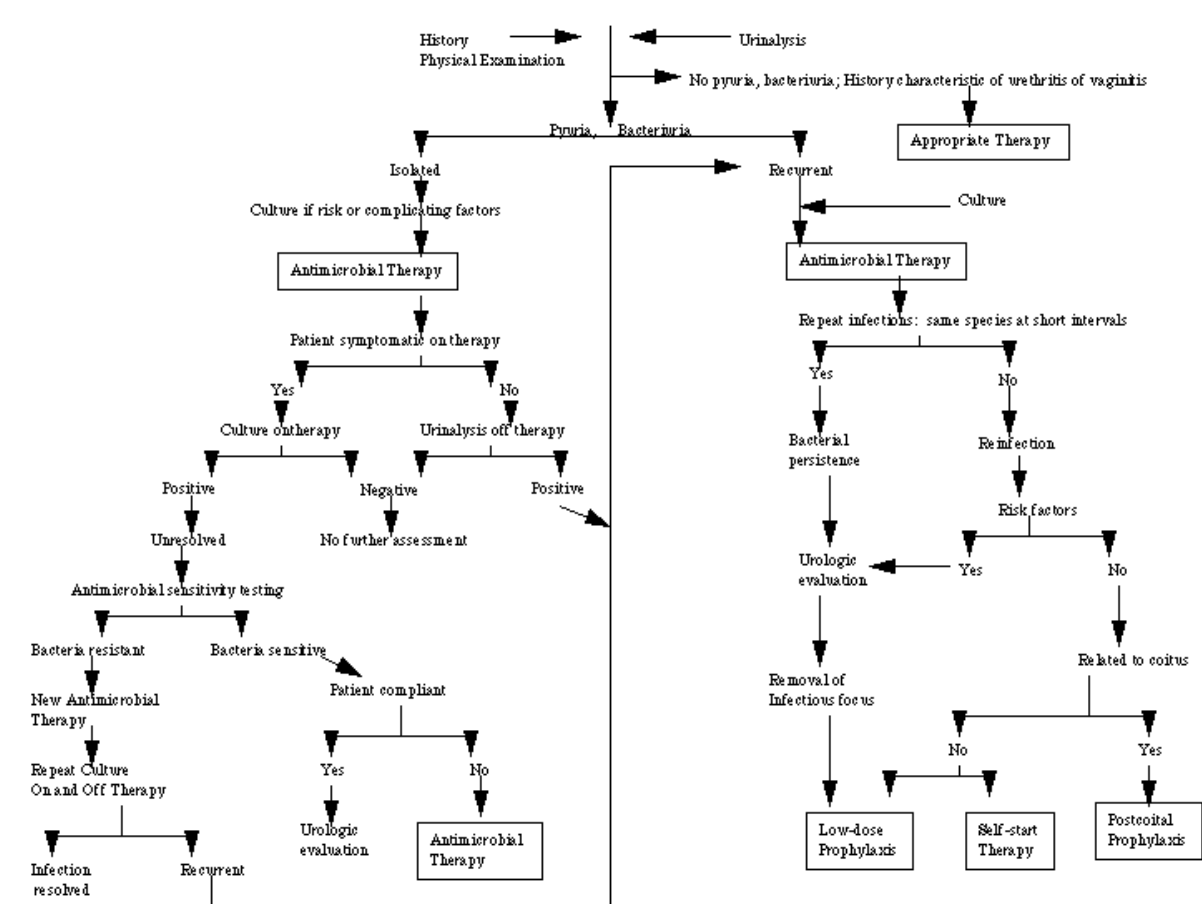
Management Strategy for Acute